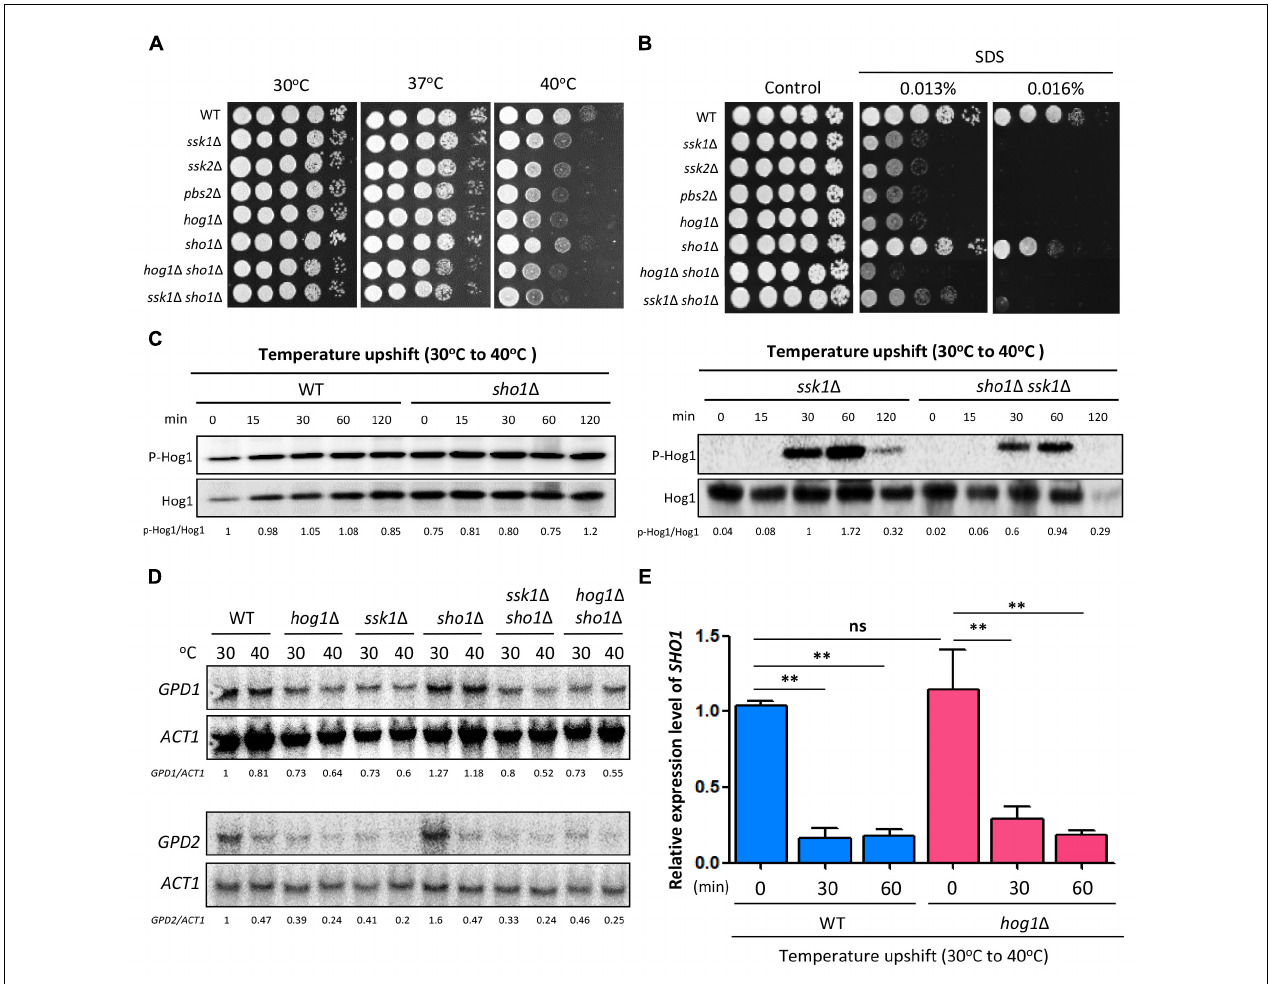
FIGURE 2 | Sho1 controls thermotolerance of C. neoformans in the Hog1-independent manner. (A) Wild-type (WT; H99), ssk1 (cid:49) (YSB261), ssk2 (cid:49) (YSB264), pbs2 (cid:49) (YSB123), hog1 (cid:49) (YSB64), sho1 (cid:49) (YSB1719), hog1 (cid:49) sho1 (cid:49) (YSB2268), and ssk1 (cid:49) sho1 (cid:49) (YSB2253) strains were grown overnight at 30 ◦ C in liquid YPD medium. To test the thermosensitivity, cells were 10-fold serially diluted (1 – 10 4 dilutions), spotted on solid YPD medium, and further incubated at 37 or 40 ◦ C. The spot assay was repeated more than three times and the one representative image was shown here. (B) To test the sodium dodecyl sulfate (SDS) sensitivity, cells were 10-fold serially diluted (1 – 10 4 dilutions) and spotted on YPD medium containing the indicated concentration of SDS. The spot assay was repeated more than three times and one representative image was shown here. (C) Strains were grown to the mid-logarithmic phase and further incubated at 40 ◦ C for the indicated time. Total protein extracts were prepared for the western blot analysis. Hog1 phosphorylation were monitored using anti-P-p38 antibody. The blot was stripped and used for detection of Hog1 with a polyclonal anti-Hog1 antibody as a loading control. These western blot analyses were repeated twice and one representative result was shown here. (D) Each strain was incubated at 30 or 40 ◦ C for 30 min. The northern blot analysis was performed with total RNAs isolated from each strain. Each membrane was hybridized with the gene-specific probe. The relative expression levels of GPD1 and GPD2 were quantitatively measured using a PhosphorImager after normalization with ACT1 expression levels ( GPD1/ACT1 and GPD2/ACT1 ). These northern blot analyses were repeated twice and one representative result was shown here. (E) The expression levels of SHO1 was verified by qRT-PCR analysis using cDNA synthesized from the total RNA isolated from WT (H99) and hog1 (cid:49) (YSB64) upon the temperature upshift from 30 to 40 ◦ C. Three independent biological experiments with triplicate technical replicates were performed. Error bars, SEM. Statistical significance of difference was determined by the one-way analysis of variance with the Bonferroni’s multiple-comparison test ( ∗∗ P < 0.01; ns,